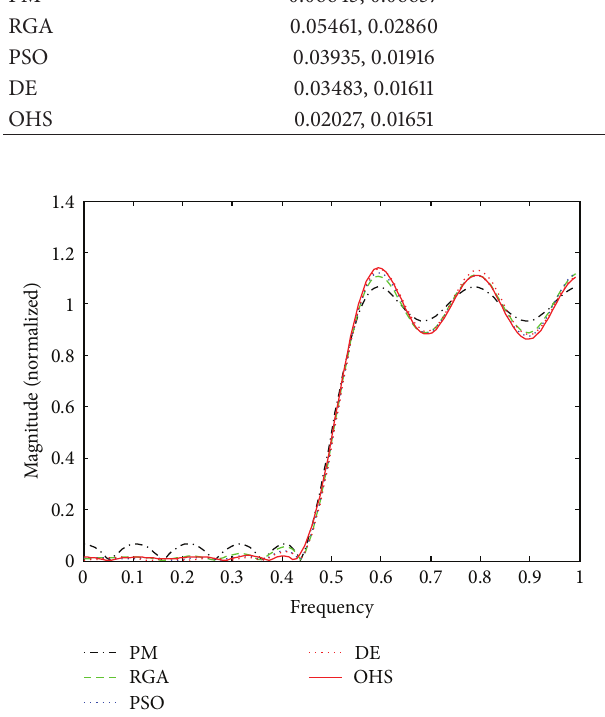
Figure 6: Normalized plots for the FIR HP filter of order 20.